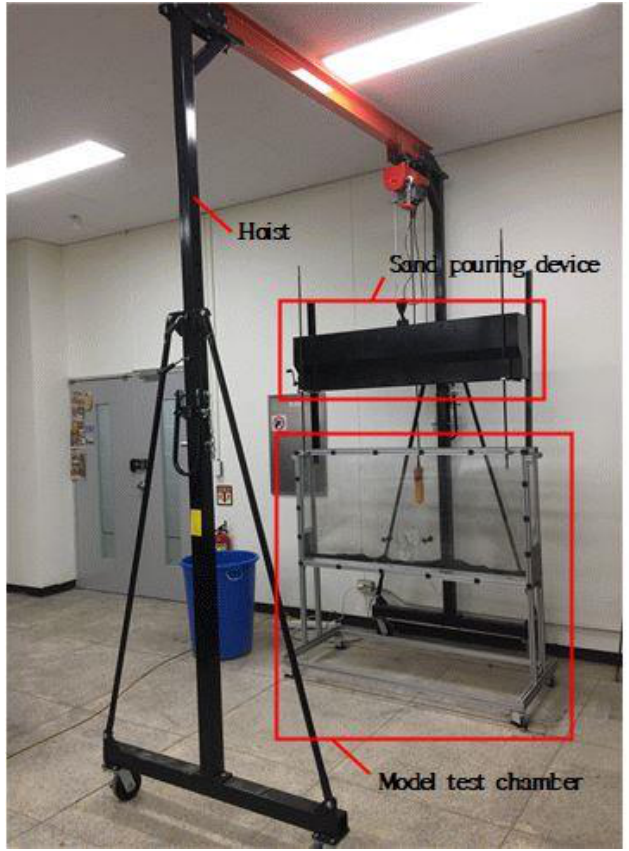
Figure 3. Sand-pouring device and model test chamber.